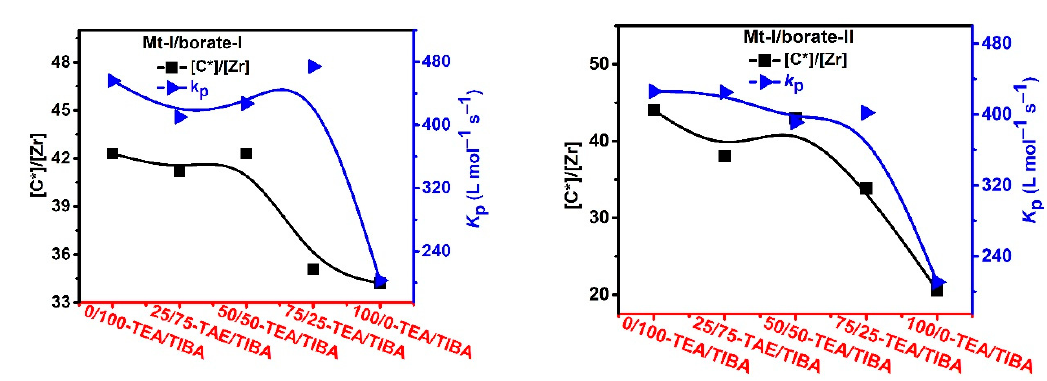
Figure 9. Active center ratio and k P of propylene polymerization with Mt-I/borate/alkylaluminum.